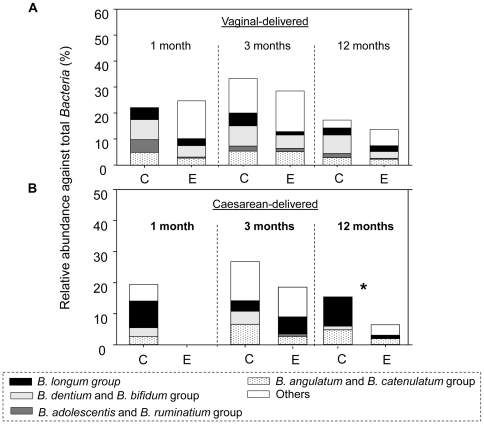
Abundances of individual species within the bifidobacterial population as quantified by HOPE.(A) Abundances found in vaginal-delivered infants (n = 27), (B) Abundances found in caesarean-delivered infants (n = 14). Abbreviation C stands for non-eczema control infants, E stands for infants with eczema. * indicates significant differences in the B. longum group found in non-eczema and eczema infants at 12 months of age.